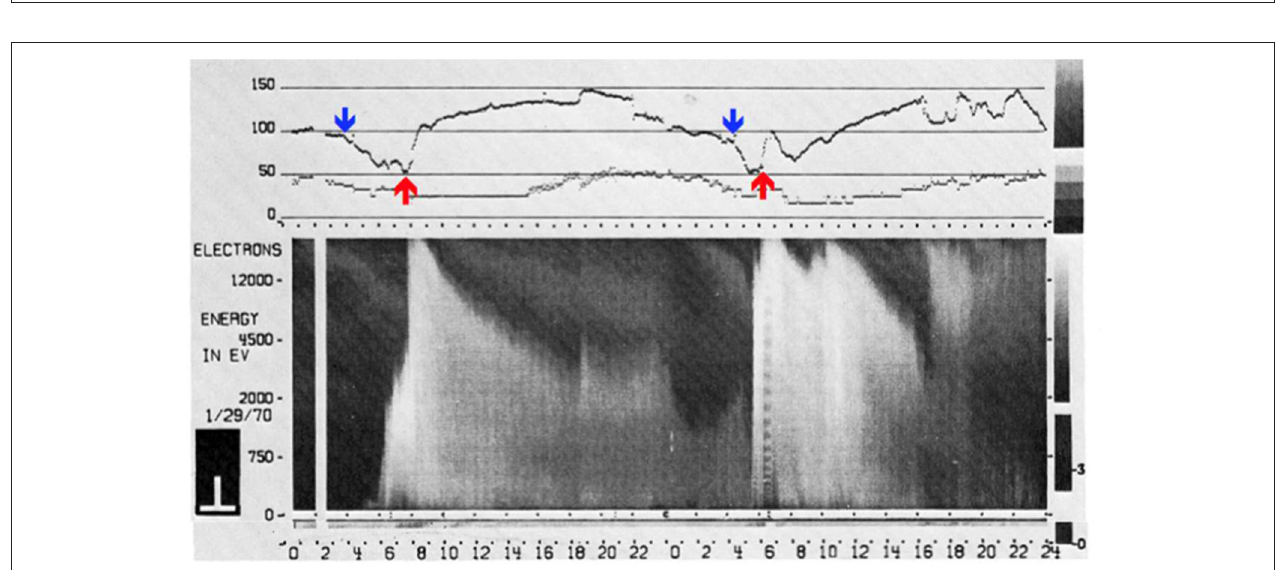
FIGURE 12 | The magnetic field observation at 6 Re during two substorms, showing a decrease of the field intensity (blue arrow) during the growth phase and subsequent sudden increase (red arrow) at the expansion onset (DeForest and McIlwain, 1971); the increase is called the dipolarization, but the field increase is often more than the